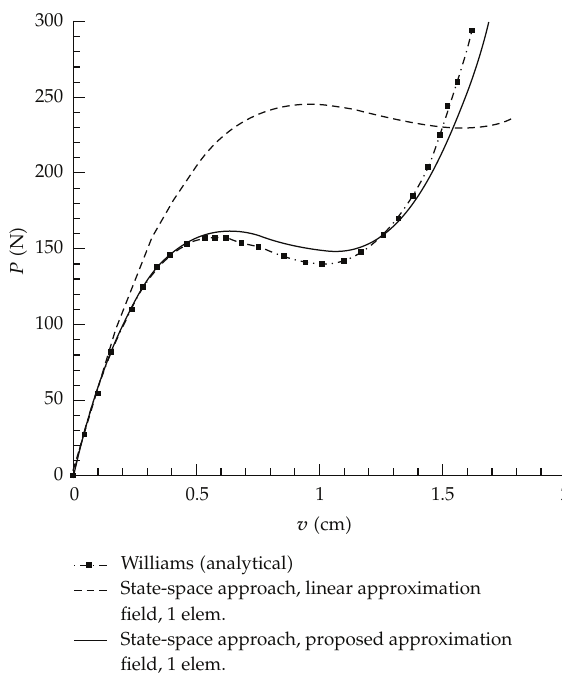
Figure 3: The equilibrium paths of toggle frame from: (cid:3) i (cid:4) analytical solution; (cid:3) ii (cid:4) state space with linear approximation, 1 element per half of the structure; 10 Lobatto points; (cid:3) iii (cid:4) state space with higher-order approximation method, 1 element per half of the structure; 4 Lobatto points.